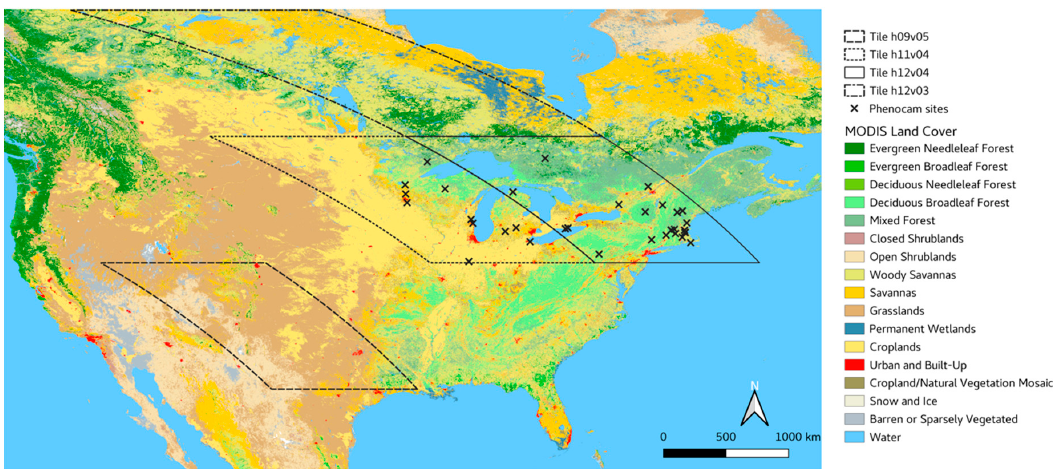
Figure 1. Map of four MODIS tiles and 47 near-surface PhenoCam sites used in the analysis. The background image shows the MODIS Land Cover Type product (MCD12Q1 C6) across the study region using the International Geosphere-Biosphere Programme (IGBP) classification.